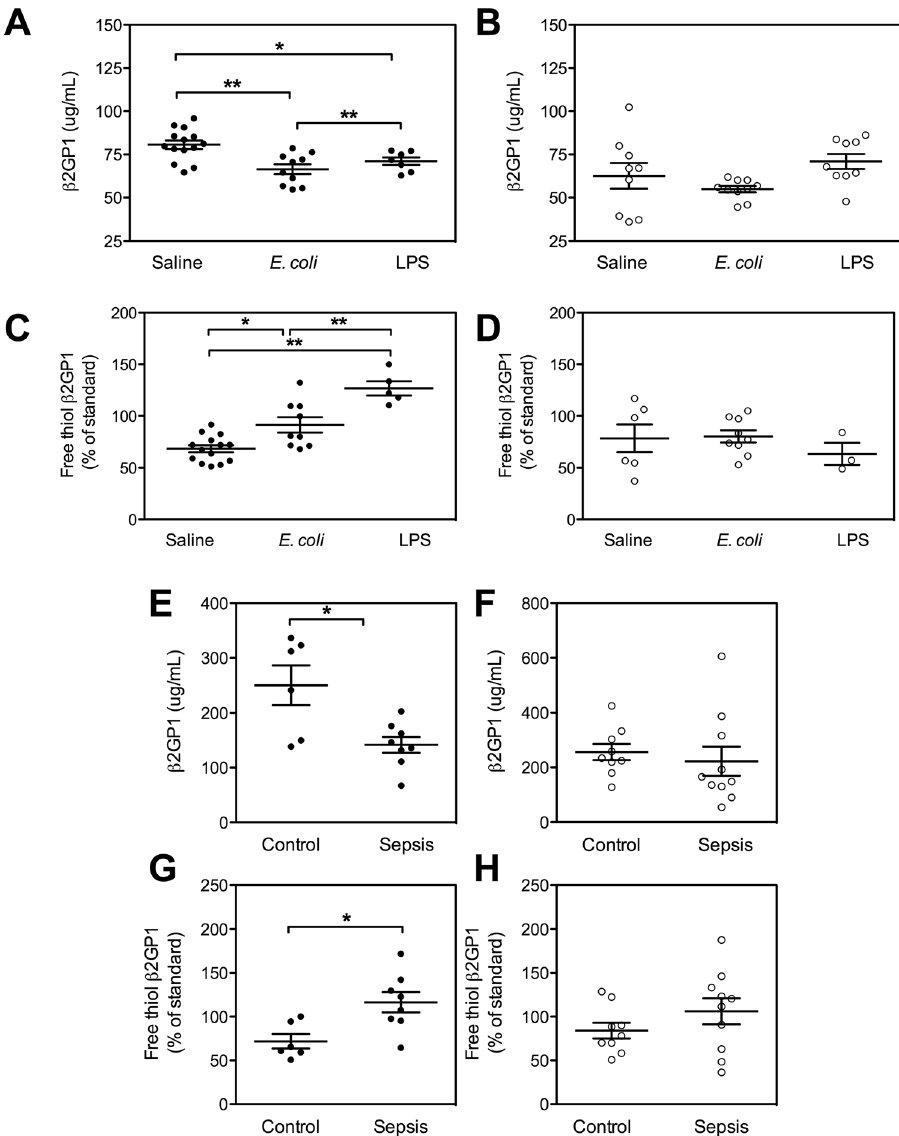
Figure 4. Plasma levels of total and free thiol β 2GPI in mice six h post E. coli or LPS challenge and in human subjects with sepsis and normal controls. Total β 2GPI levels ( A ). Male and ( B ). Female mice, following E. coli or LPS challenge (male n = 14 saline, n = 10 E. coli, n = 7 LPS and female n = 9 saline, n = 10, E. coli , n = 7 LPS). Free thiol β 2GPI ( C ). Male and ( D ). Female mice, following E. coli or LPS challenge (male n = 14 saline, n = 10 E. coli, n = 10 LPS and female n = 9 saline, n = 9 E. coli , n = 10 LPS). Total β 2GPI in patients with sepsis ( E ). Male and ( F ). Female patients compared to healthy controls ( n = 9 male sepsis, n = 6 male control, n = 8 female control, n = 10 female sepsis). Free thiol β 2GPI in patients with sepsis ( G ). Male and ( H ). Female compared to healthy controls (male sepsis n = 8, female sepsis n = 10, male control n = 6, female control n = 9,). Male = ● , Female = ○ , Data represented as mean ± SEM, Mann-Whitney * p < 0.05, ** p <